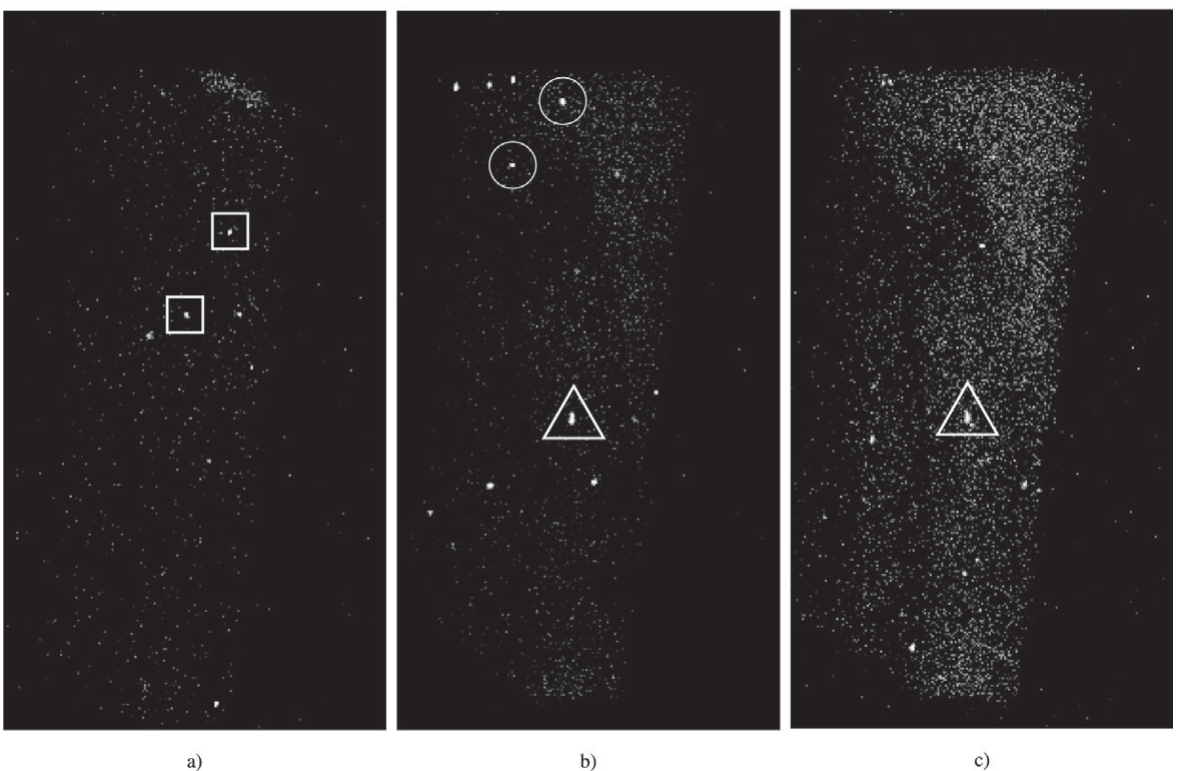
Figure 4. X-ray images for 2 θ = 44.44°, corresponding to a) First image of the sequence, obtained at room temperature; b) Image obtained when the temperature has just reached 380 °C.; c) Last image of the sequence, after a period of time at the stable temperature of 380